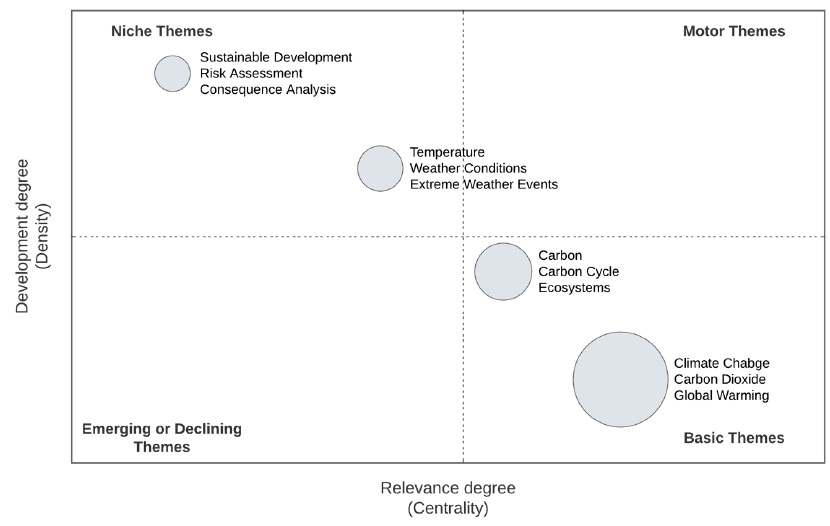
Figure 5. Thematic map.